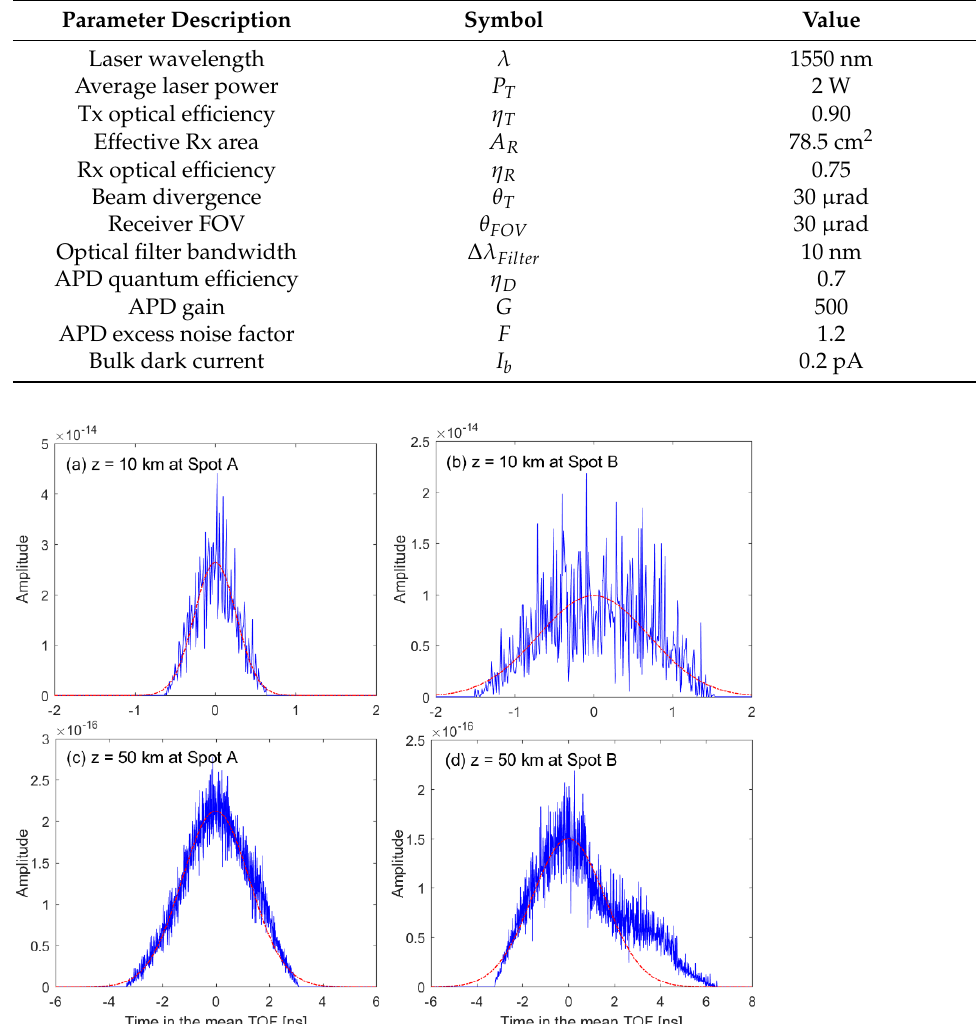
Figure 4. Backscattered waveforms of impulse response at the height of z = 10 km and z = 50 km for spot A and spot B, respectively, and their fitting functions. The blue solid line represents the impulse response, and the red dash-dotted line corresponds to the fitting function which indicates the broadened pulse width.